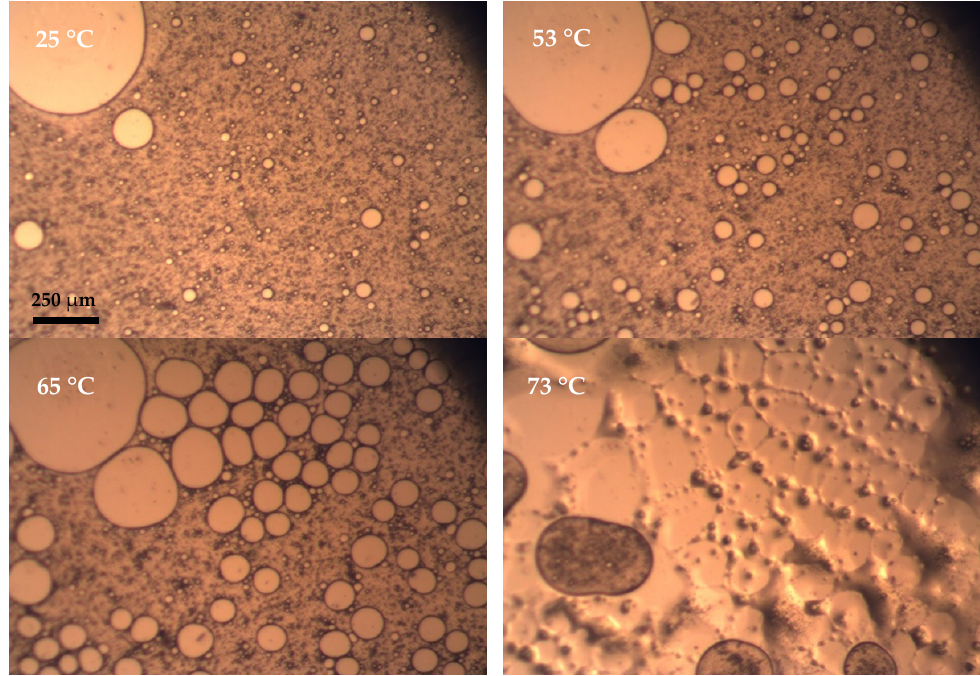
Figure 3. Images of the PFH emulsion with 1% of Zonyl ® recorded as a function of the temperature.